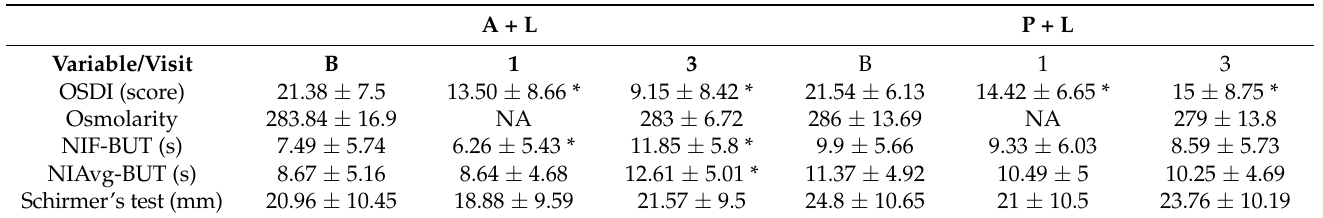
Table 6. Quantitativevariablesanalysisindry-eyepatientsexposedtotheoralstudy formulation + lubricant or placebo + lubricant.